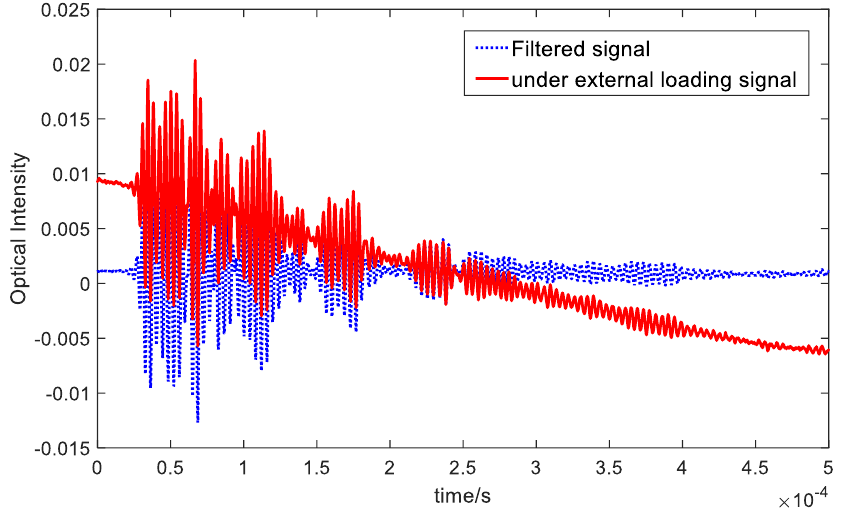
Figure 15. FBG-based FP sensor signals recorded under a varying external load on a pristine plate.